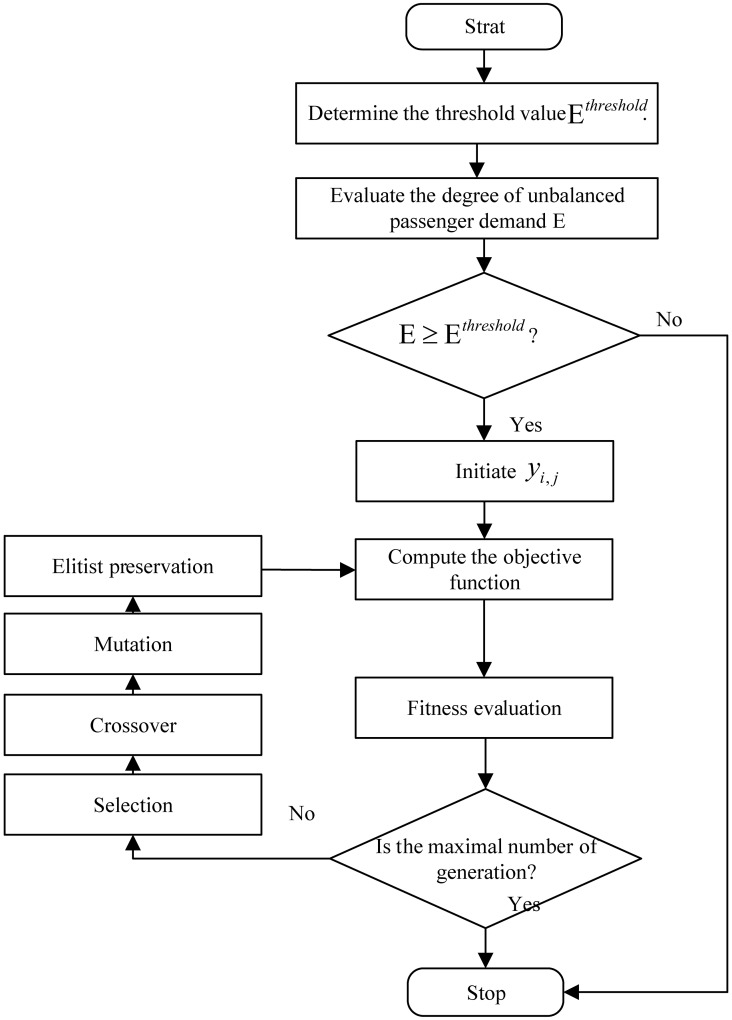
Solution algorithm.